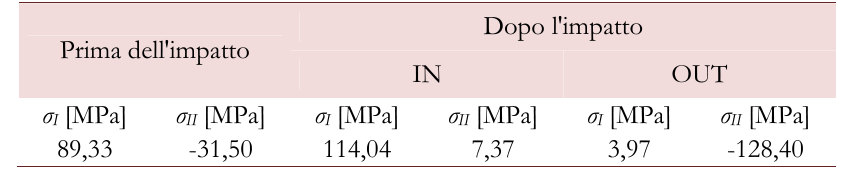
Tabella 7: Valore medio delle tensioni residue rilevate prima e dopo le prove di impatto balistico; dopo l’impatto sono state considerate separatamente le zone di ingresso e di uscita del proiettile per evidenziare